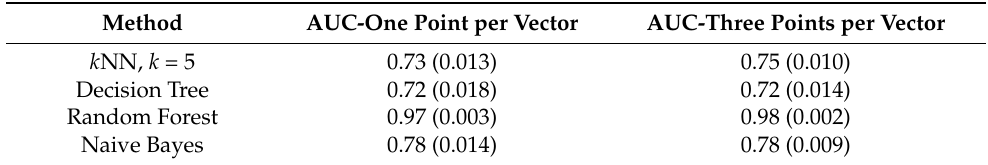
Table 3. The Area Under Curve averaging results for each method, calculated for two scenarios and averaged over ten classification runs. Values in brackets represent standard